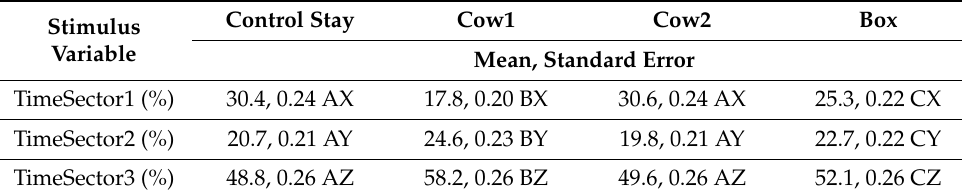
Table 3. The time spent in Sectors 1, 2 and 3 as related to the stimulus.